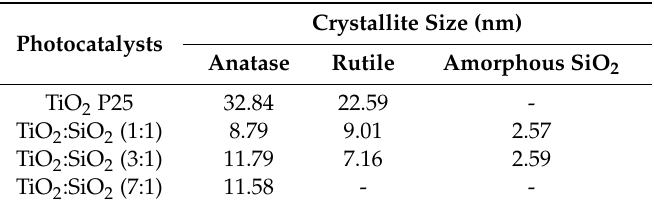
Table 2. The crystallite size of photocatalysts.